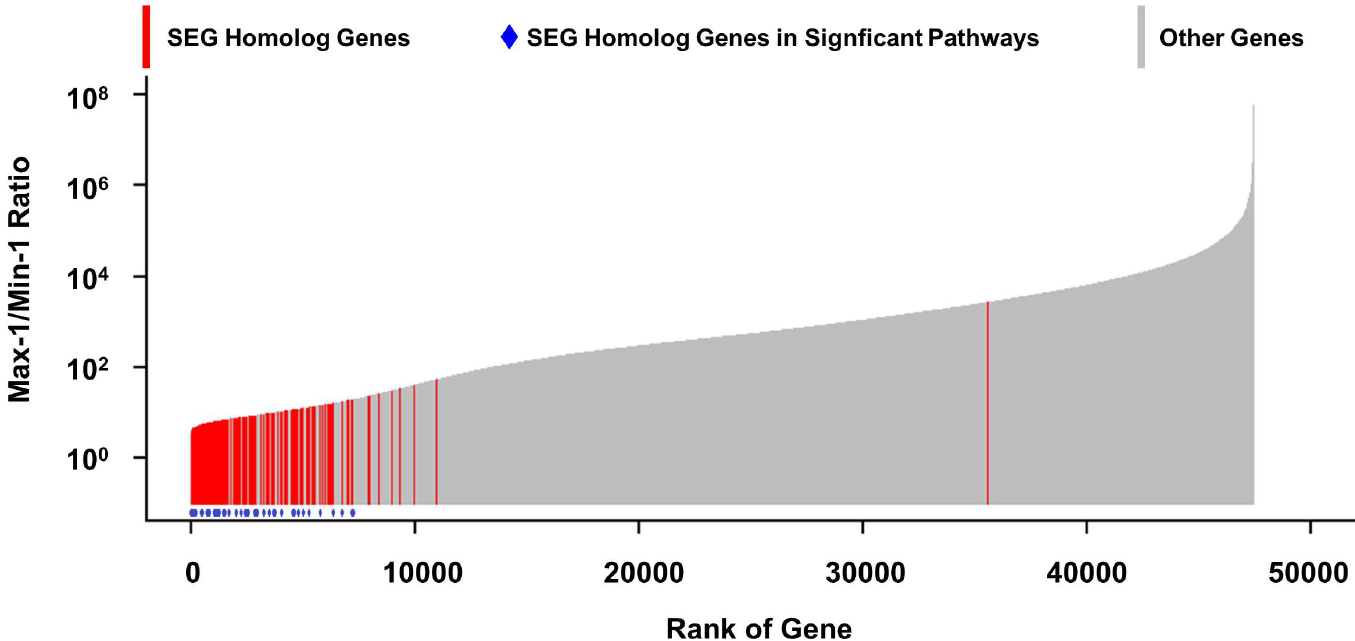
Fig 3. Expression stability of human homologs of SEGs. Each bar represented a gene, with the height corresponding to the expressionchange (maximum expression–minimumexpression). The SEG homologs are red and those associated with significantpathways identifiedin Table 1 are marked with a blue